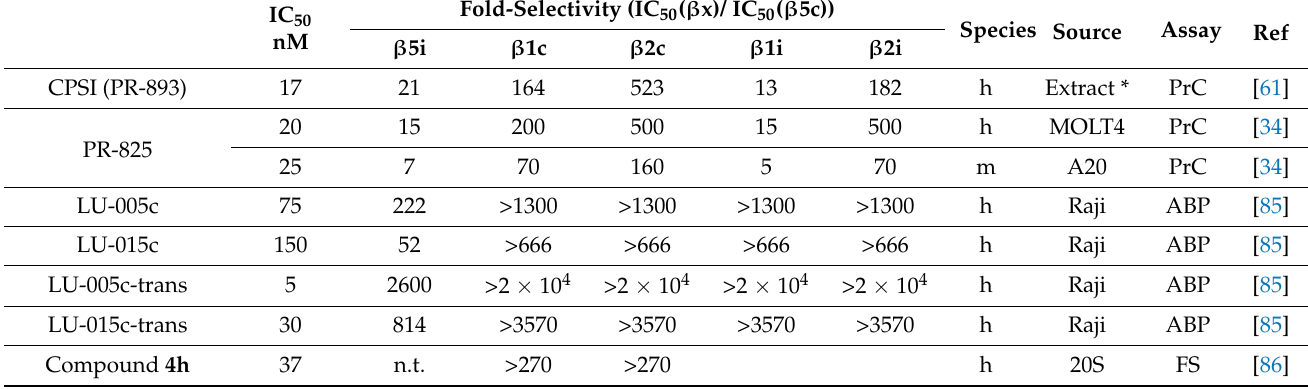
Figure 7. β 5c inhibitors. Table 4. β 5c